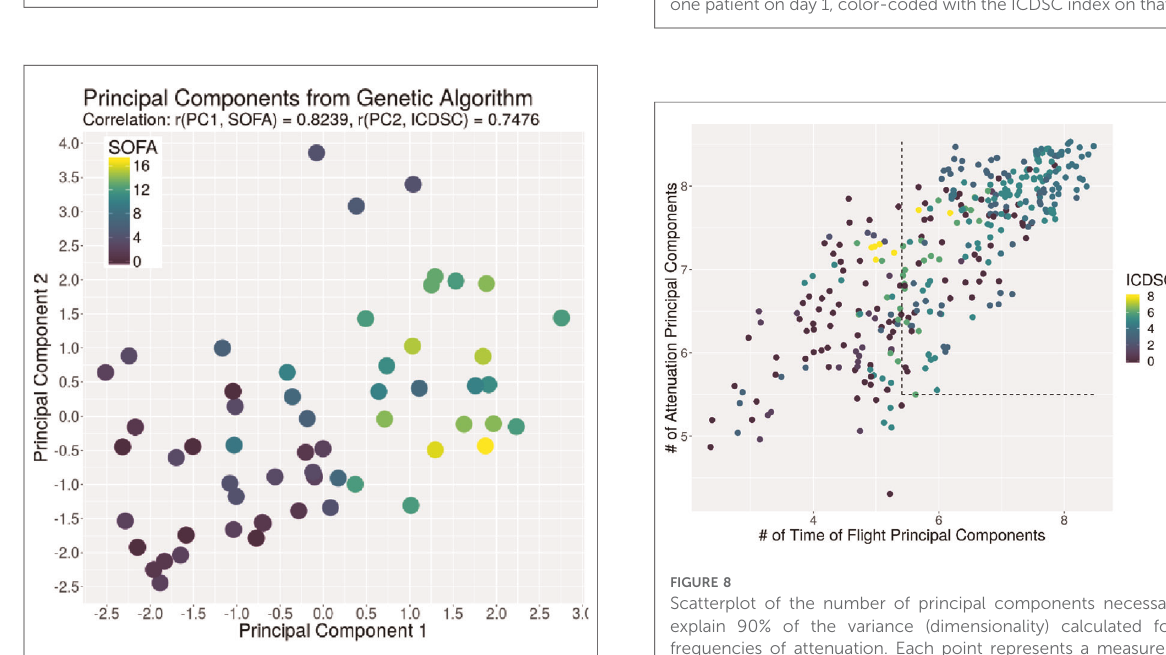
FIGURE 6 Plot of the principal component derived by the GA based on the SOFA score on the x -axis and the principal component derived by the GA based on the ICDSC on the y -axis. Every dot represents one patient on day1, color-coded with the SOFA index on that day. algorithm were analyzed in Figures 10 and 11 . Figure 10 shows the relation of the feature with the ICDSC score, and Figure 11 shows the relation with the SOFA score.